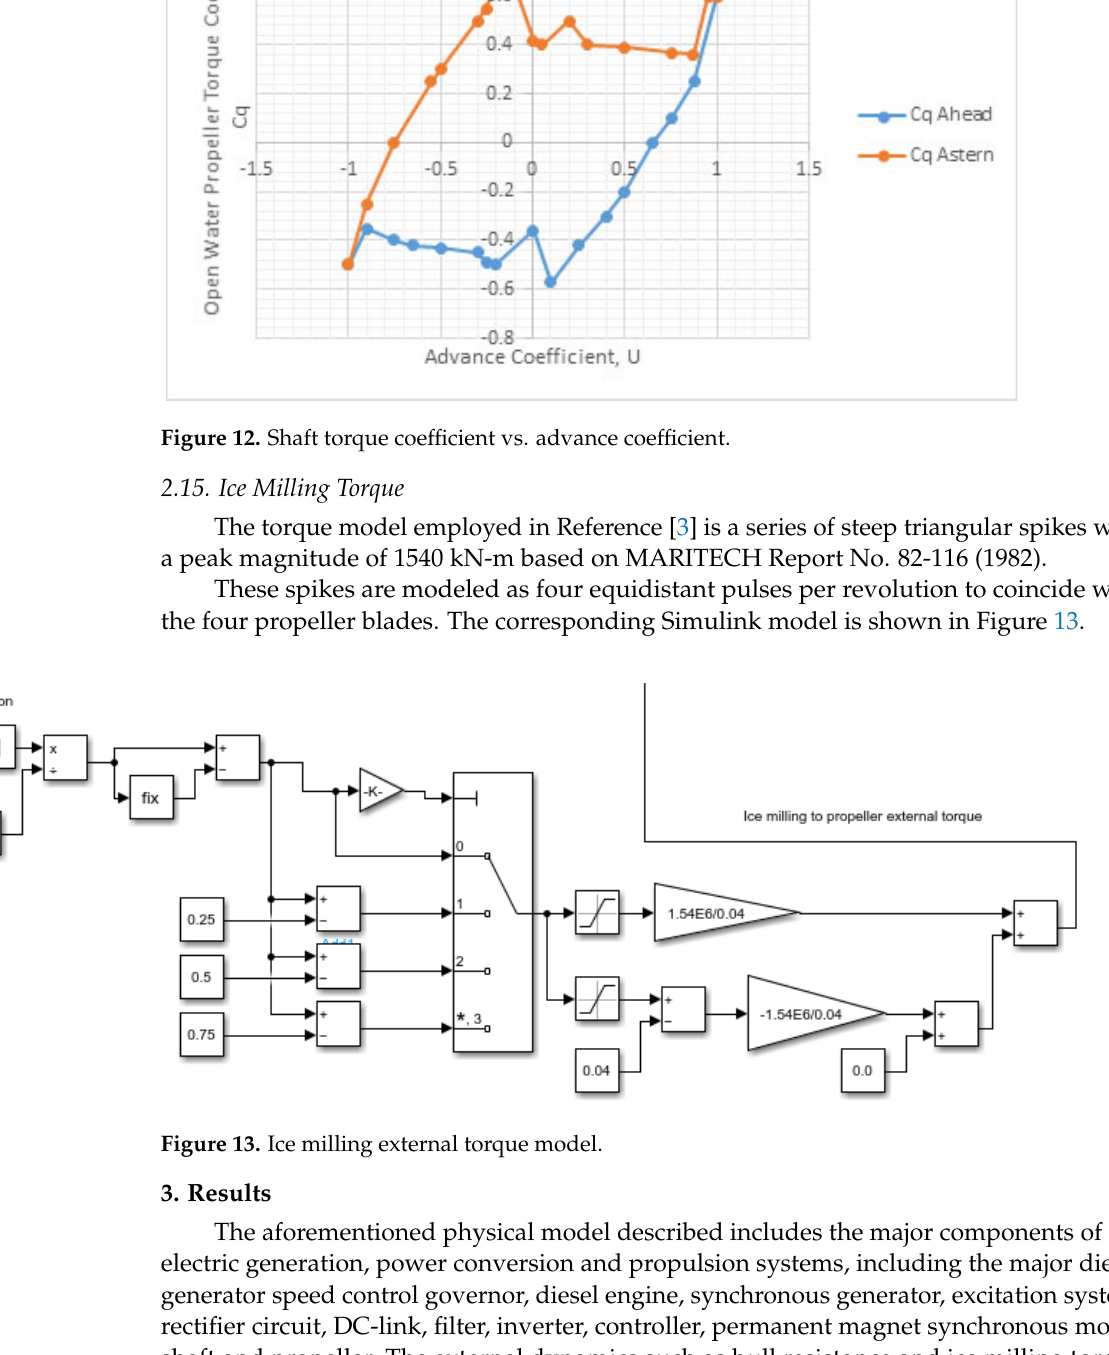
Figure 11. Shaft thrust coefficient vs. advance coefficient.